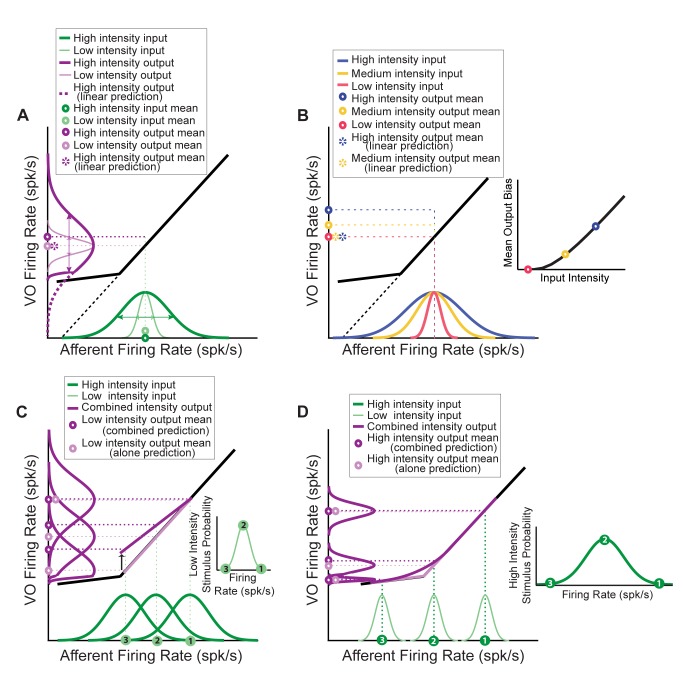
Schematic showing how a nonlinear static relationship between input and output can lead to attenuated sensitivity to sums of low and high frequency stimuli.(A) Input-output relationship showing a vertex (i.e., a sudden change in slope) (black curve). If we assume that the input is normally distributed with low intensity (i.e., standard deviation) such that all the input values are to the right of the vertex (light green distribution on x-axis), then the corresponding output distribution will also be normally distributed (light purple distribution on y-axis). The mean output (light purple circle on y-axis) corresponds to the image of the mean input (dashed purple circle on y-axis; note that the light purple and dashed purple circles were offset for clarity) as both input and output are linearly related. In contrast, for a higher intensity input that extends significantly past the vertex (dark green distribution on x-axis), the corresponding output distribution (dark purple on y-axis) is skewed with respect to the linear prediction (dashed purple on y-axis). The mean output (dark purple circle on y-axis) is thus greater than the linear prediction (dashed purple circle on y-axis). (Note that here and below, we represented the distributions to have the same maximum value in order to emphasize the fact that we are changing the standard deviation.) (B) Increasing the input distribution intensity for a given mean (compare red, yellow, and blue distributions) causes a greater skew in the corresponding output distribution (unpublished data) and thus an increased bias in their means (red, yellow, and blue dots on the y-axis and inset) as compared to the linear prediction (dashed yellow and blue dots on the y-axis). (C) Shifting the mean of the high intensity input distribution to the left (compare points 1, 2, and 3 on the x-axis and the inset) makes it extend to the left of the vertex more and more (compare the green curves on the x-axis), causing greater skewness in the corresponding output distributions (purple curves on the y-axis), which creates a greater bias in the mean (dark purple points on y-axis) with respect to the linear prediction (light purple points on y-axis). As a result, the mean output in response to a given value of the low intensity input (points 1, 2, and 3 on the x-axis) when the high intensity signal is present (dark purple line) has a lower slope (i.e., gain) than when the high intensity signal is absent (light purple line). (D) Shifting the mean of the high intensity input distribution to the left (compare points 1, 2, and 3 on the x-axis and the inset) makes the corresponding distributions of the low intensity input extend to the left of the vertex more and more (green curves on the x-axis), causing greater skewness in the output distribution (purple curves on the y-axis), which creates a greater bias in the mean (dark purple points on y-axis) with respect to the linear prediction (light purple points on y-axis). Note, however, that the bias in the mean will be lower than in (C) since the input distributions now have a lower intensity as explained in (B). Thus, the input-output relationship when the low intensity signal is present (dark purple line) will have a lower slope (i.e., gain) than when the low intensity signal is absent (light purple line) but the effect will be weaker than in (C).